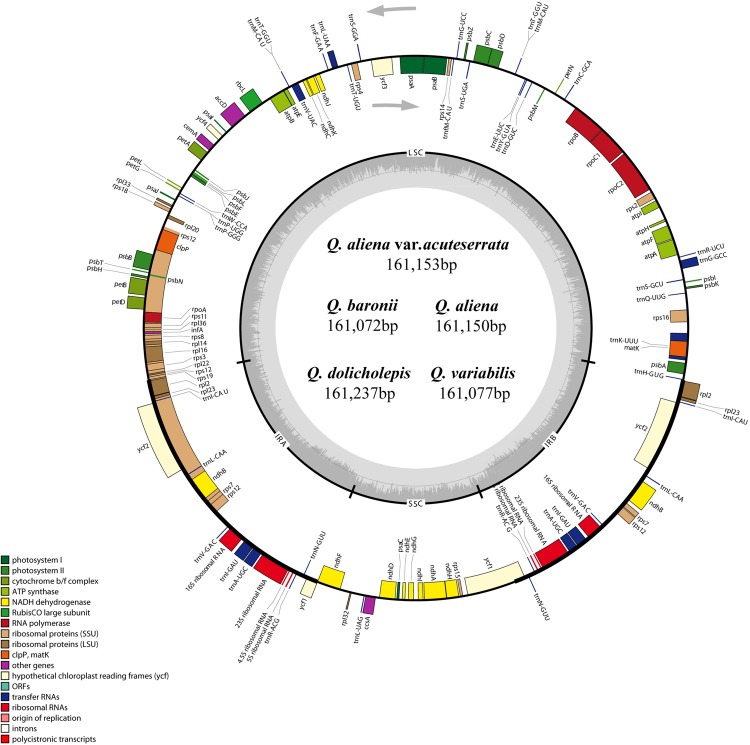
Gene map of the five Quercus chloroplast genomes. The genes shown outside of the circle are transcribed clockwise, while those inside are transcribed counterclockwise. Genes belonging to different functional groups are color coded. Dashed area in the inner circle indicates the GC content of the chloroplast genome.